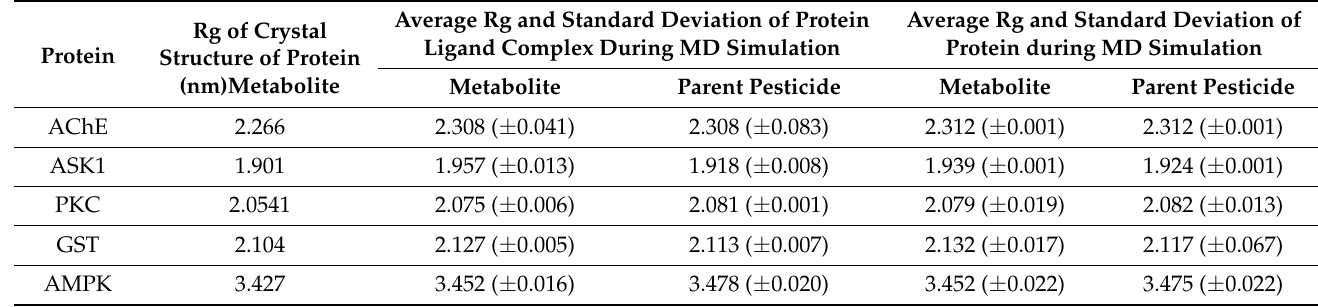
Average Rg and Standard Deviation of Protein during MD Simulation